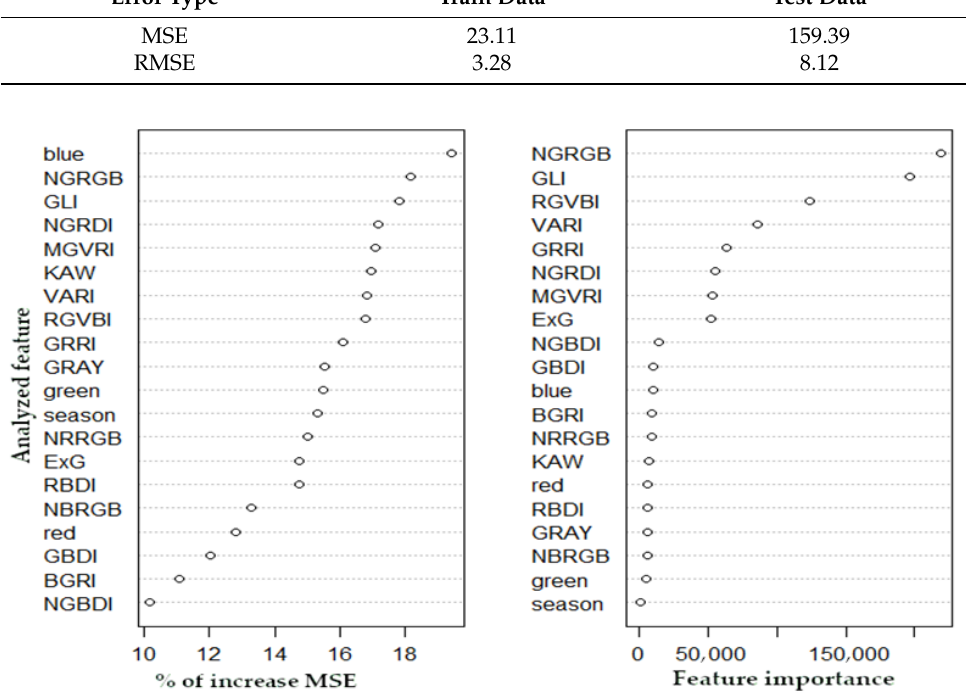
Figure 6. The variable’s importance for each component is expressed as a percent of MSE in the random forest algorithm ( left ), and feature importance is expressed as an increase in node purity ( right ). Higher values reflect that variable has more importance in the model.